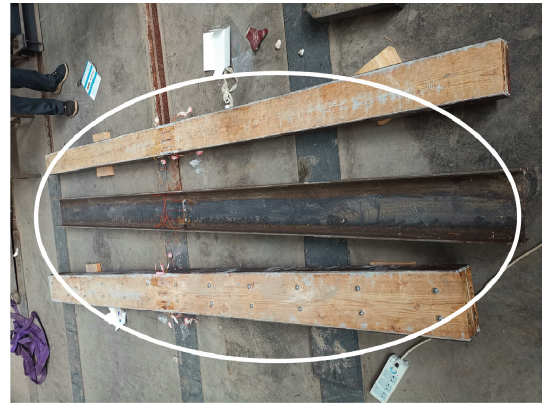
Figure 2: Test beam. Table 1: Main parameters of